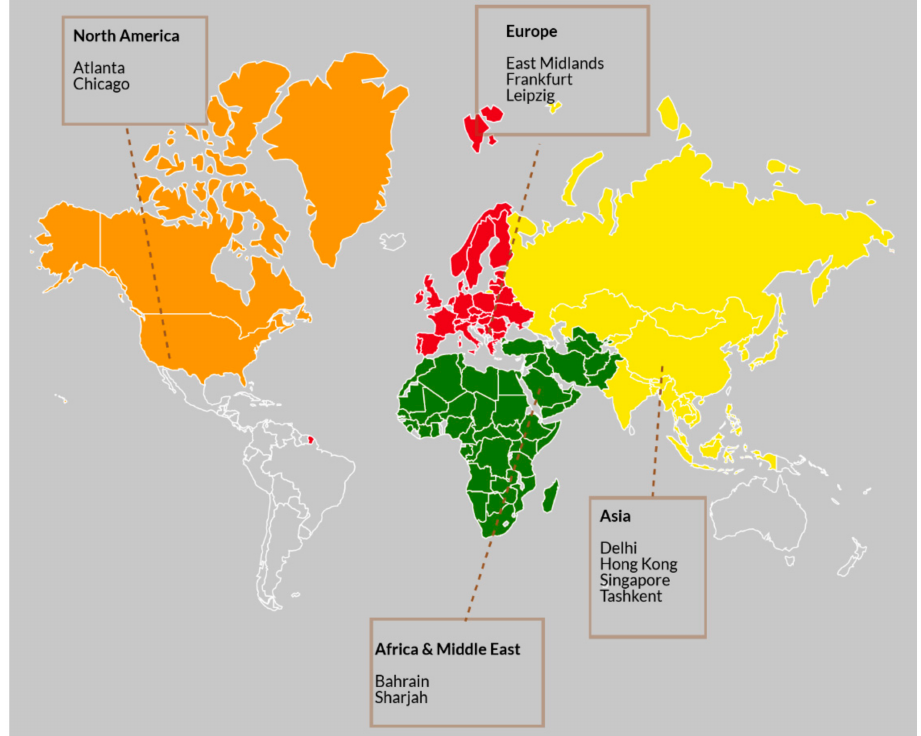
Figure 3. The AeroLogic route network: Winter 2009/2010 schedule. Legend: ATL–Atlanta; BAH–Bahrain; DEL–Delhi; EMA–East Midlands; FRA–Frankfurt; HKG–Hong Kong; LEJ–Leipzig/Halle Airport; ORD–Chicago; SHJ–Sharjah; SIN–Singapore; TAS–Tashkent. Source: